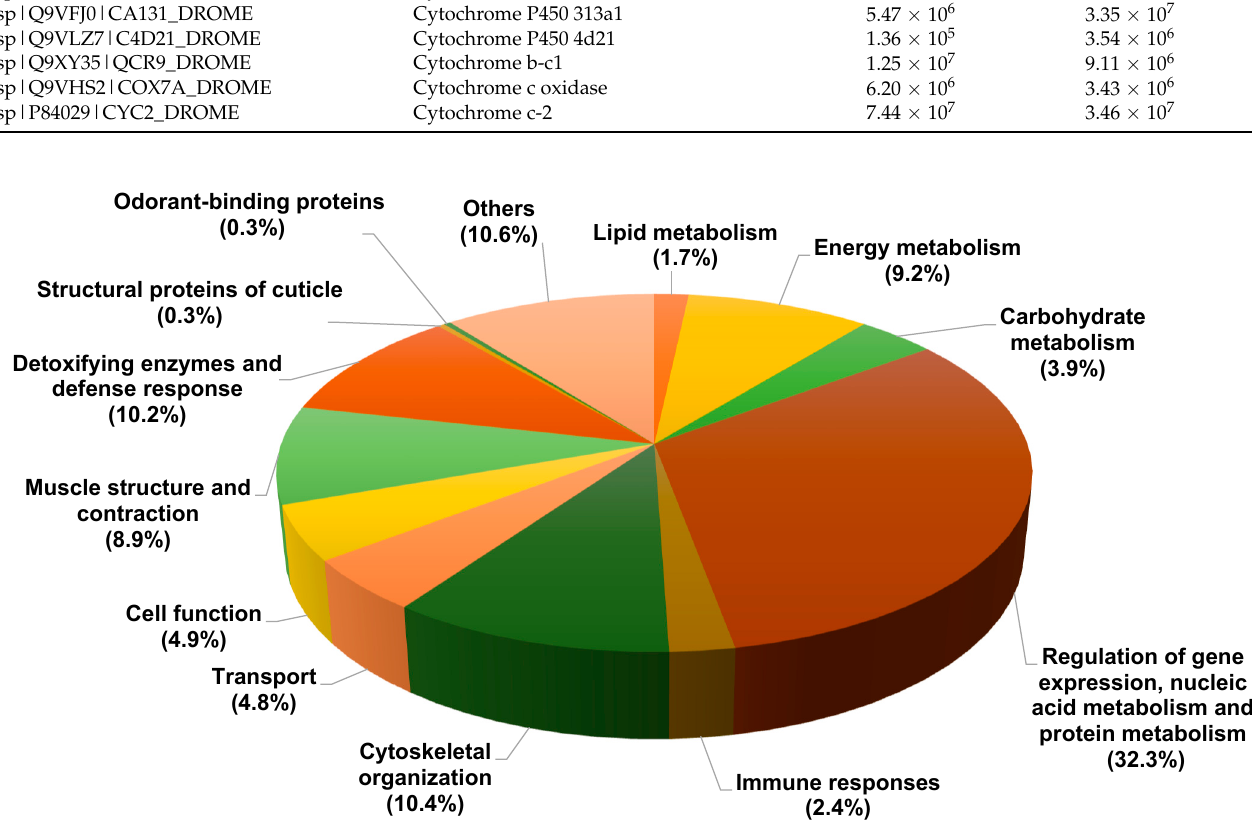
Figure 2. Distribution of all proteins identified in Drosophila melanogaster proboscis (proteins identified in females and males are pooled here) . The 586 proteins belong to 13 functional categories shown in this pie chart representation (the percentage indicated for each category is relative to the total number of proteins; each protein was counted in only one category).